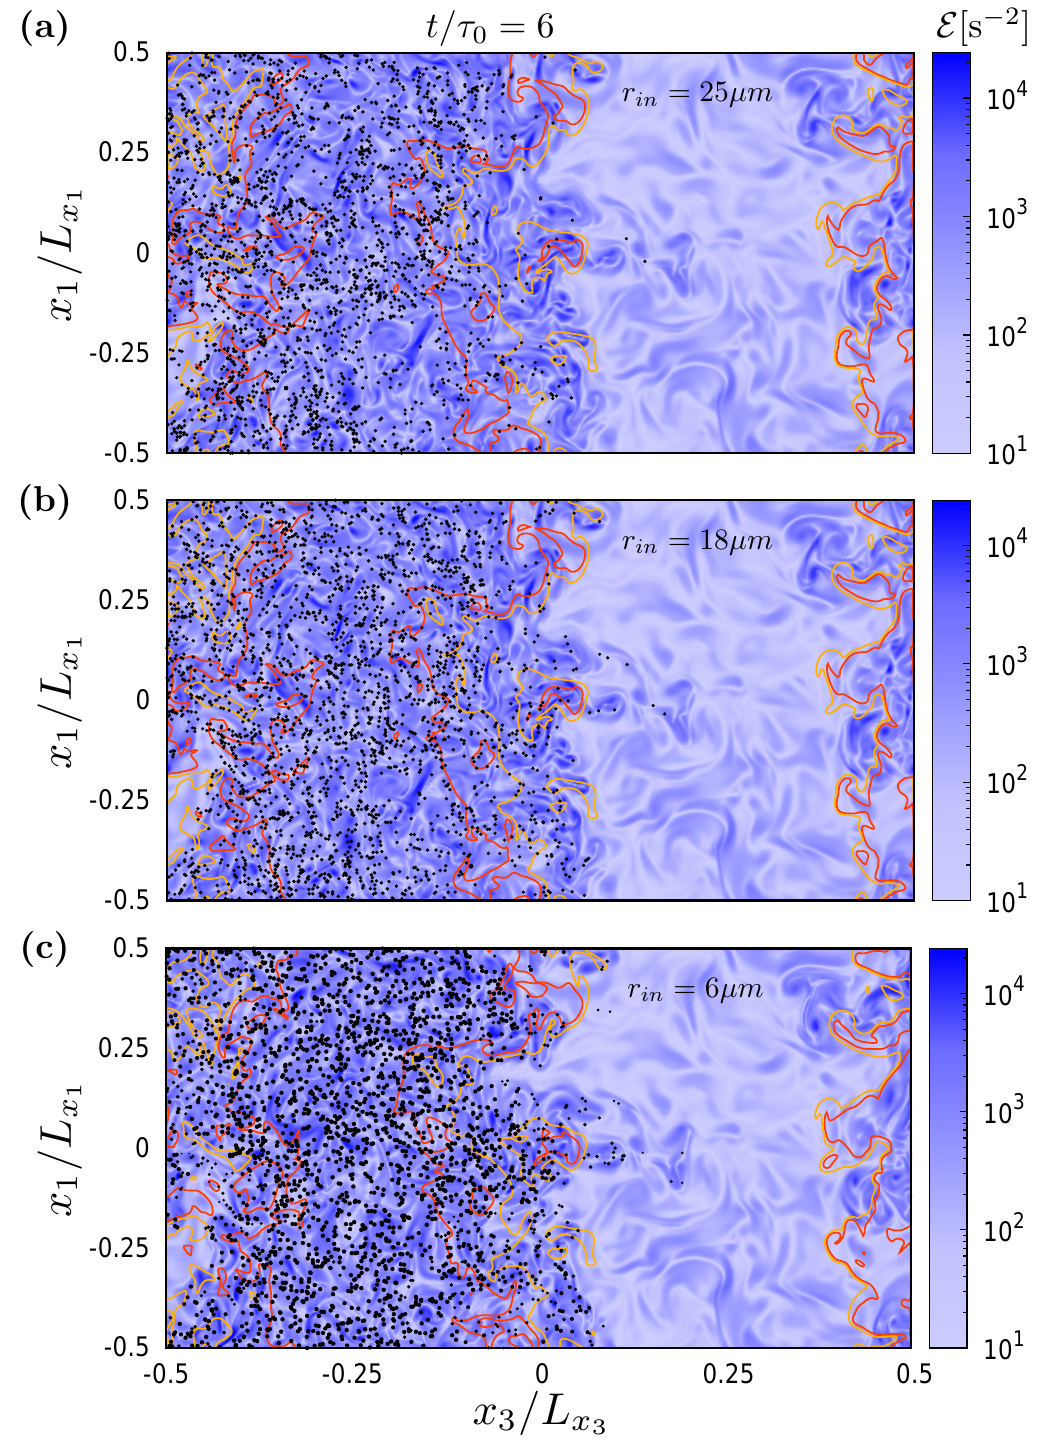
Figure 6. Visualization: Enstrophy E field across a vertical plane (plane ( x 3 , x 1 ) ) is presented in superposition with the supersaturation S field in contour lines and cloud droplets around that plane (thickness of droplets containing slice is 0.0025 m) after 6 initial eddy ( t / τ 0 = 6) turnover time. Colourbar represents magnitude of the enstrophy in the flow field, red and yellow contour lines represent saturated ( S = 0) and subsaturated ( S = 0.2) conditions respectively. The sizes of the − droplets are proportional to r / r in for each population. The panels show the simulations with the droplet populations of ( a ) 25 µ m; ( b ) 18 µ m; and ( c ) 6 µ m initial